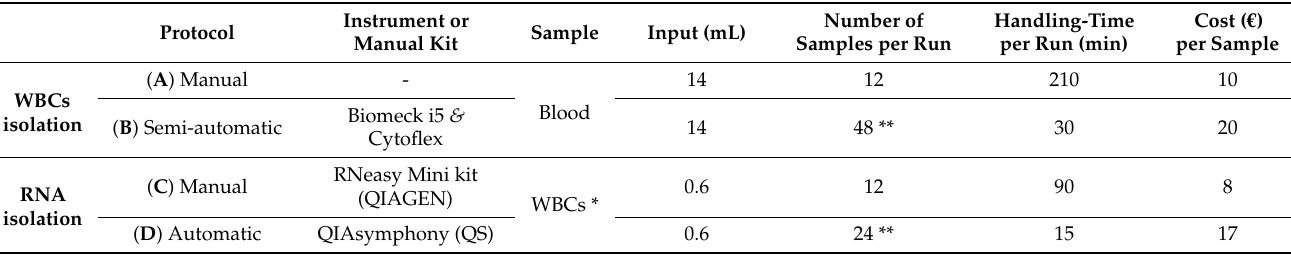
Table 2. Description of manual and semiautomatic